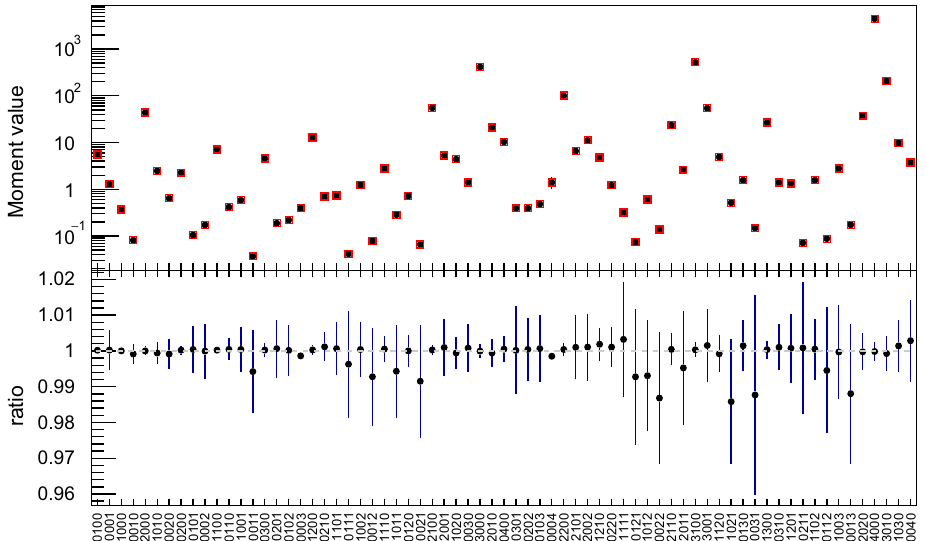
Fig. 5 Reconstructed (black circles) and generated (red squares) moments and their ratio. The ratio uncertainty values for moments 0003 and 0004, omitted from the plot for clarity, equal 1.00 ± 0.07 and 1.00 ± 0.55,